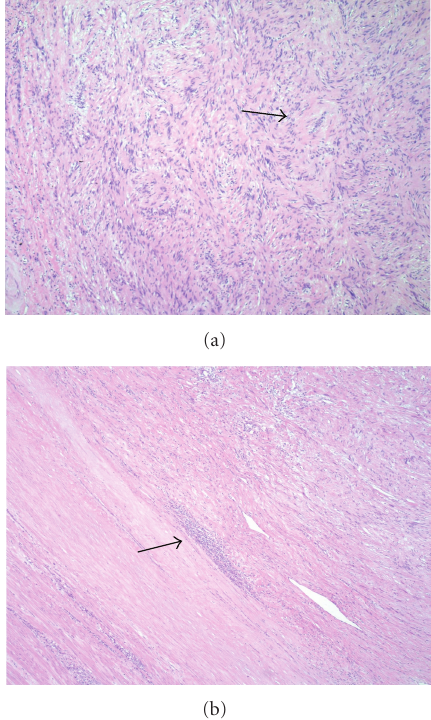
Figure 6: (a) Spindle cell proliferation with relatively bland cyto- logy and focal nuclear palisading ( arrow ) (H&E, × 200); (b) lym- phocytic cu ffi ng ( arrow ) at the peripheral part of the tumor is a common feature (H&E, × 100).